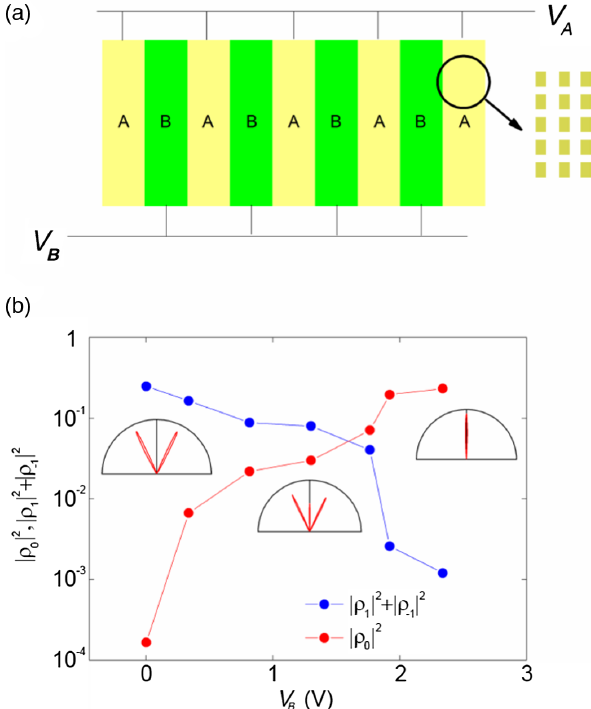
FIG. 14. Numerical simulation of a gate-tunable diffraction grating. (a) Schematics of the device with the stripes A and B, consisting of pixels of the same size as that of the pixels in samples A and B in Fig. 3. (b) Plots of the zero- and first-order ¼ 1 . 32 V and reflectances of the device against V for V B A f ¼ 0 . 48 THz. The insets depict the normalized scattering patterns of the device for normally incident plane waves at three ¼ 0 , 1.29, and 2.34 typical gating voltages ( V B